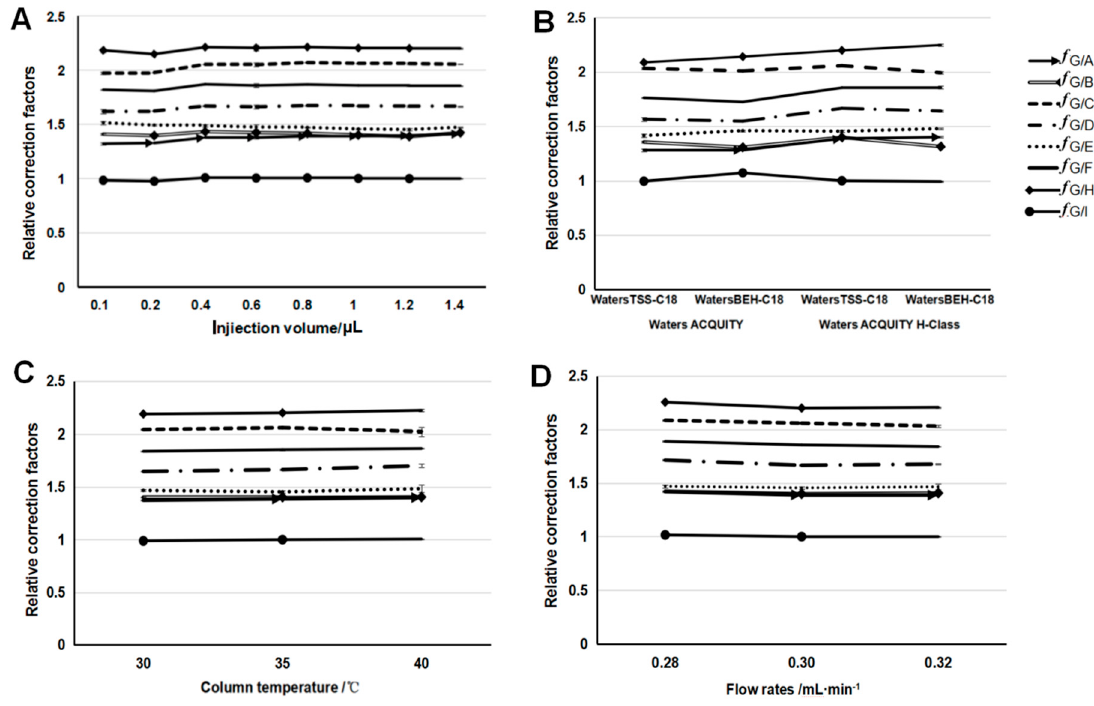
Figure 2. Results of the relative calibration factors (RCFs) and robustness test (mean ± SD, n = 3). ( A ) RCFs of different injection volumes; ( B ) RCFs of different instruments and different columns; ( C ) RCFs of different column temperatures; ( D ) RCFs of different flow rates in the mobile phase. Note: f G/A: sibiricose A5; f G/B: sibiricose A6; f G/C: sibiricaxanthone B; f G/D: glomeratose A; f G/E: polygalaxanthone III; f G/F: tenuifoliside B; f G/H: tenuifoliside A; f G/I: tenuifoliside C.